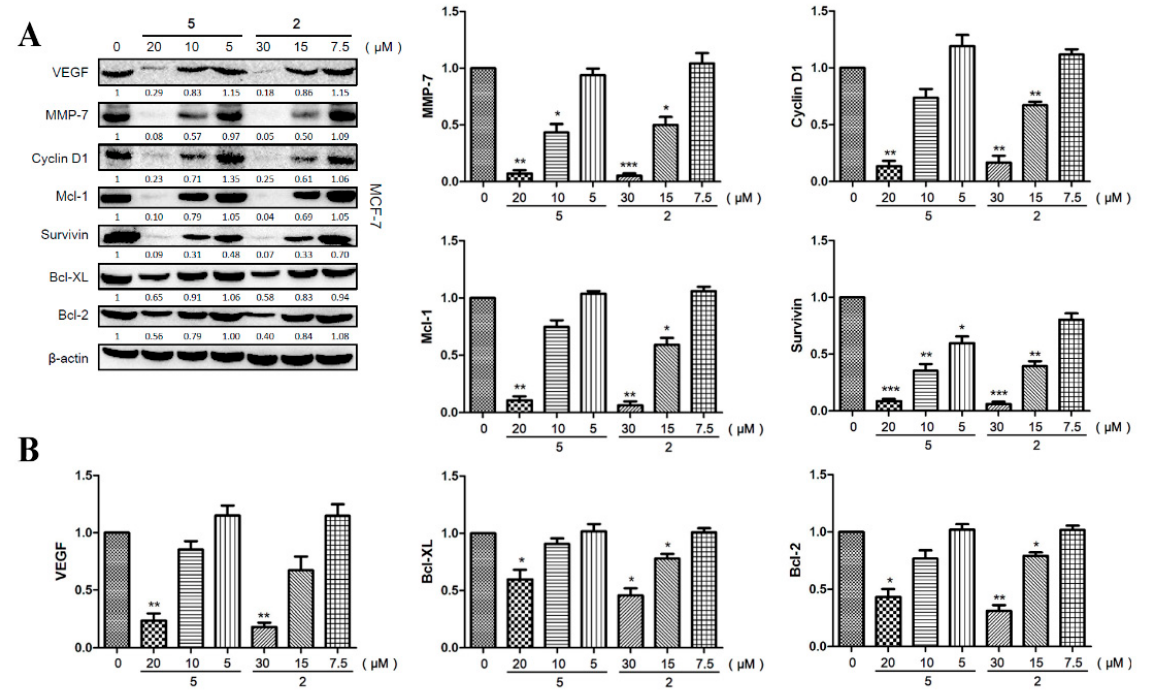
Figure 7. Suppressive effects of compounds 2 and 5 on the expression of downstream effector proteins of STAT3 in MCF- 7cells. The cells were incubated with compound 2 or 5 for 6 h with the indicated concentrations. ( A ) The protein levels of VEGF, MMP-7, Cyclin D1, Mcl-1, Survivin, Bcl-XL, Bcl-2, and β -actin were detected by western blotting. ( B ) Fold changes of Western blotting ( n = 3). Data represent mean ± SD. * p < 0.05, ** p < 0.01, *** p < 0.001 compared with the control group.